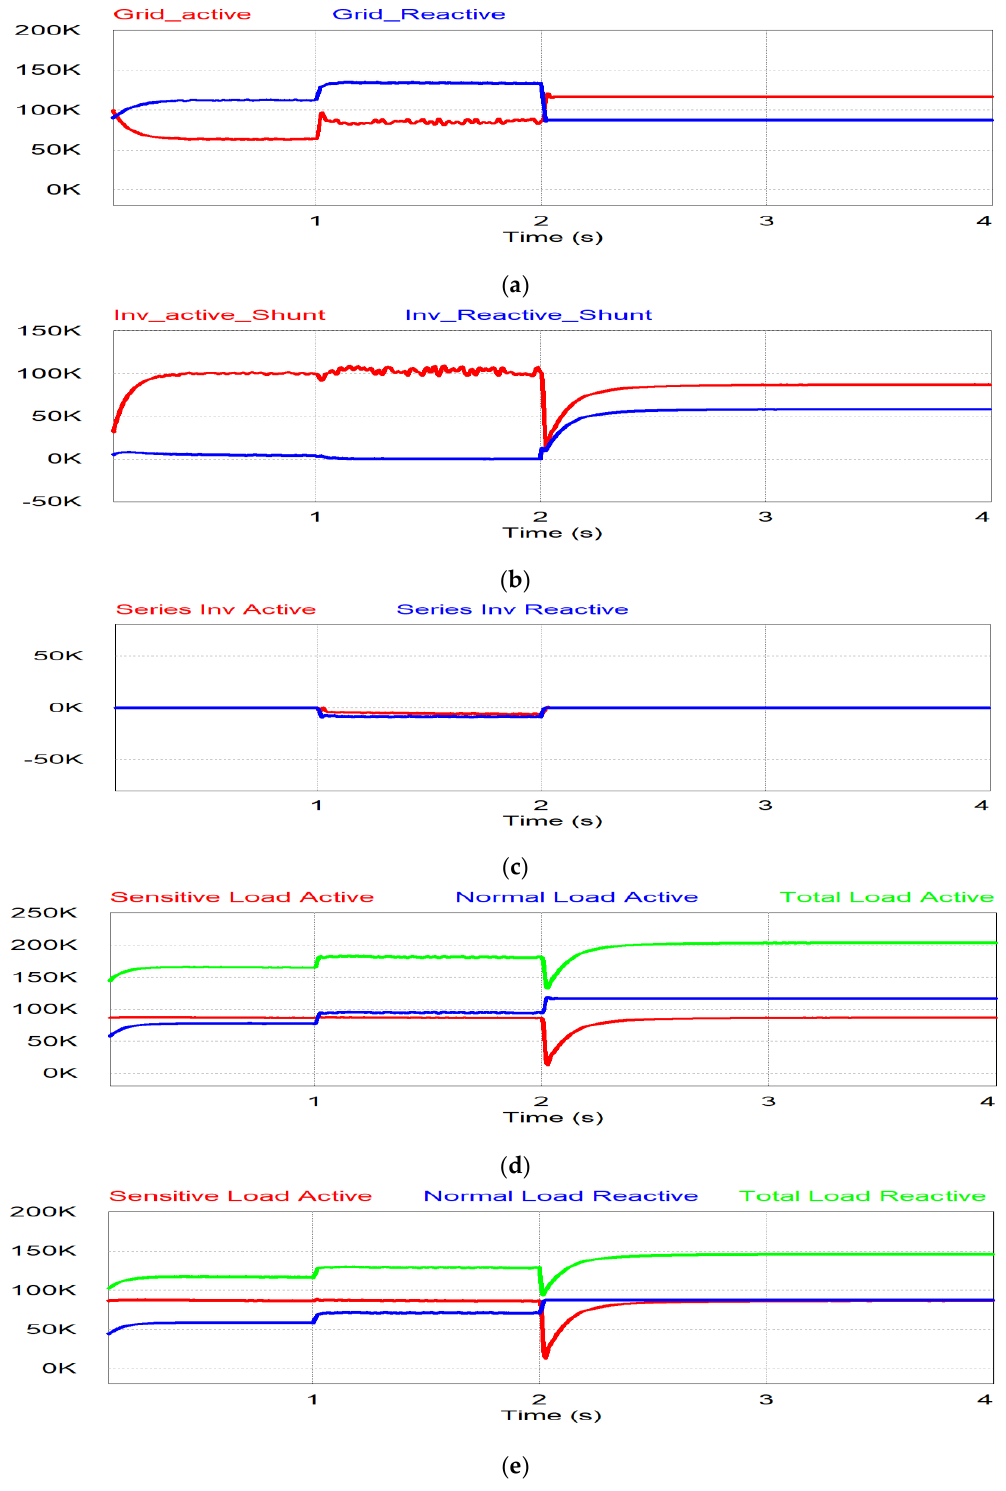
Figure 16. Simulation results of overvoltage: ( a ) Grid power; ( b ) shunt inverter power; ( c ) series inverter power; ( d ) active power for sensitive, normal and total load; ( e ) reactive power for sensitive, normal and total load.